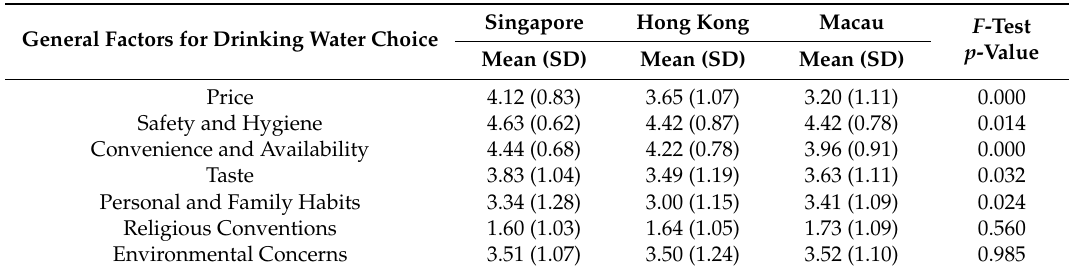
Table 3. General factors for drinking water choice.